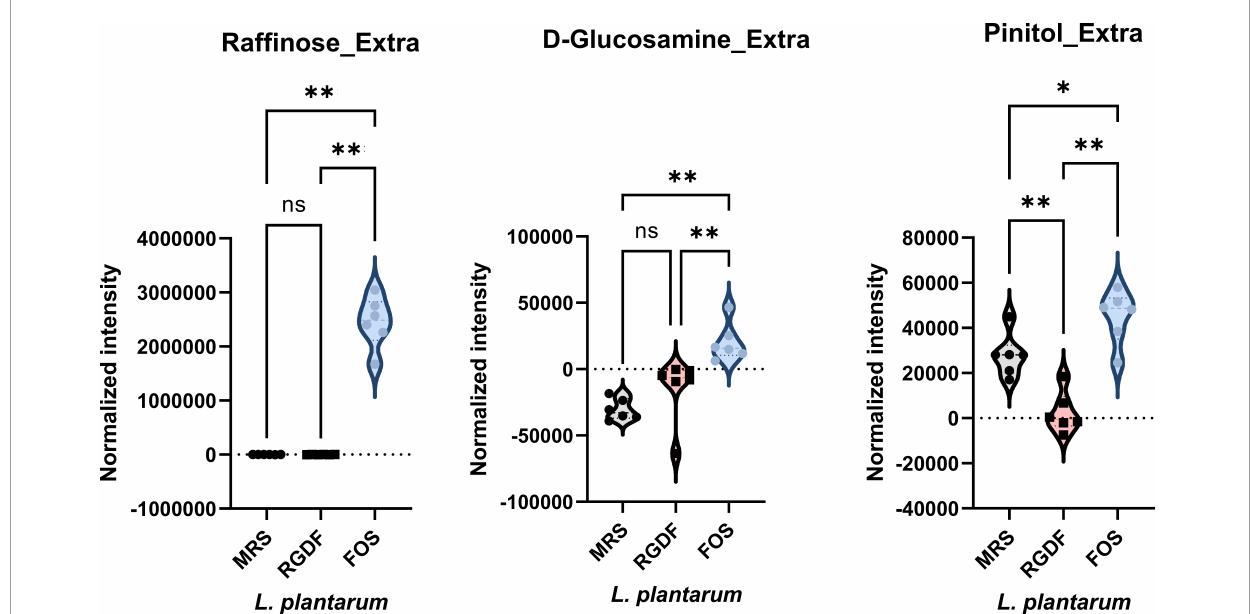
FIGURE6 Normalized abundance of extracellular metabolites of L. plantarum cultured with 0.5% (w/v) RGDF or 0.5% (w/v) FOS. Data are expressed as violin plots of six determinations. Differences were indicated at a significance level of 95% ( ∗ ) and 99% ( ∗∗ ), as determined by one-way ANOVA with Tukey’s post-hoc